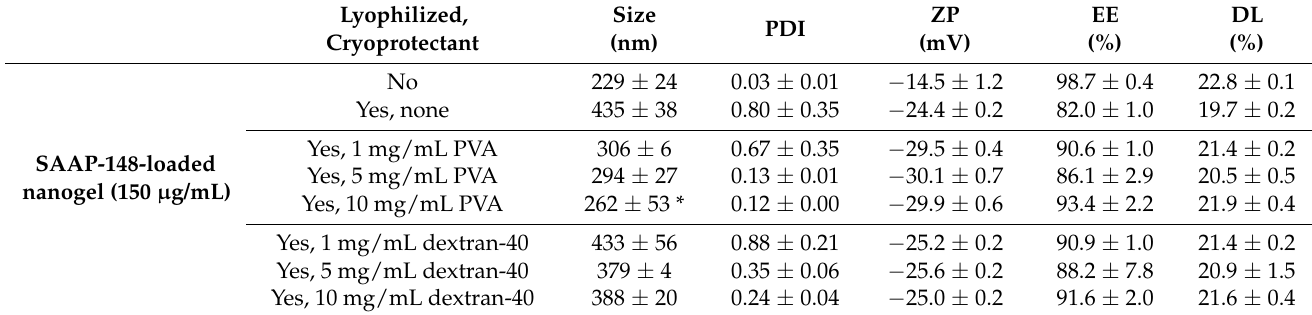
Table 2. Physicochemical properties of redispersed SAAP-148-loaded and placebo OSA-HA nanogels upon lyophilization in presence of the cryoprotectants PVA or dextran-40.